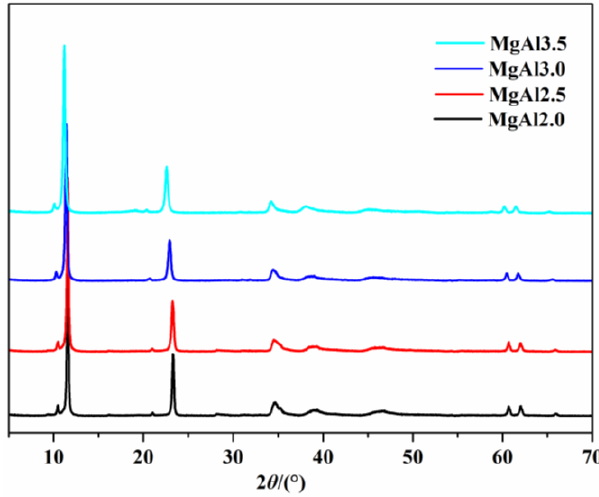
Figure 5. XRD patterns of LDHs with Mg/Al molar ratios of 2.0, 2.5, 3.0, and 3.5.